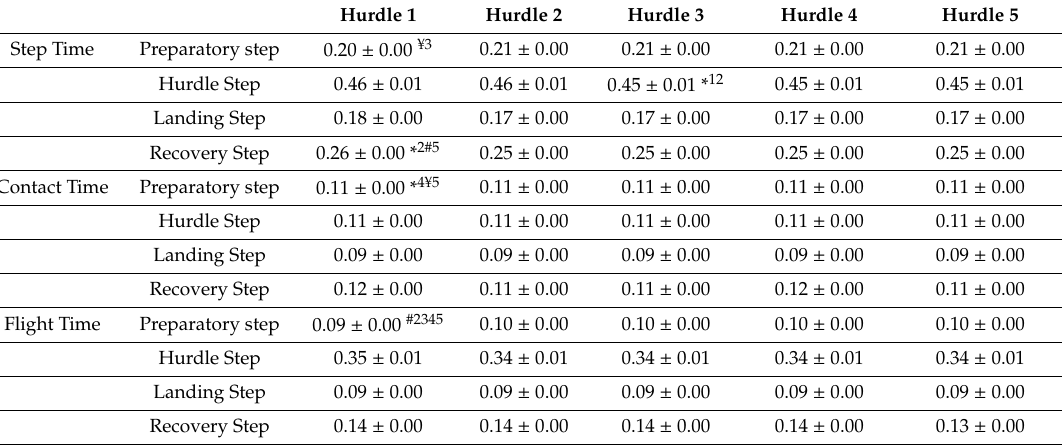
Table 3. Evolution of the spatial-temporal variables of women hurdlers participating in the 44th Spanish Indoor and 12th IAAF World Indoor